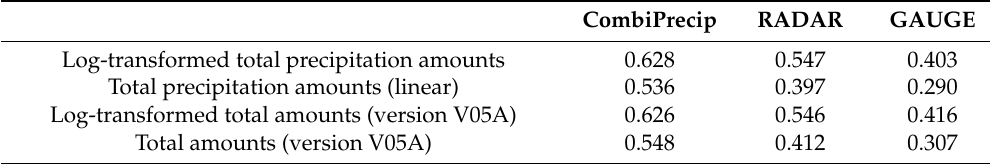
Table 1. Pearson correlation coefficients between the estimates of the Global Precipitation Measurement radar (versions V04A and V05A) above 221 Swiss sites and the estimates derived from three different MeteoSwiss precipitation products.